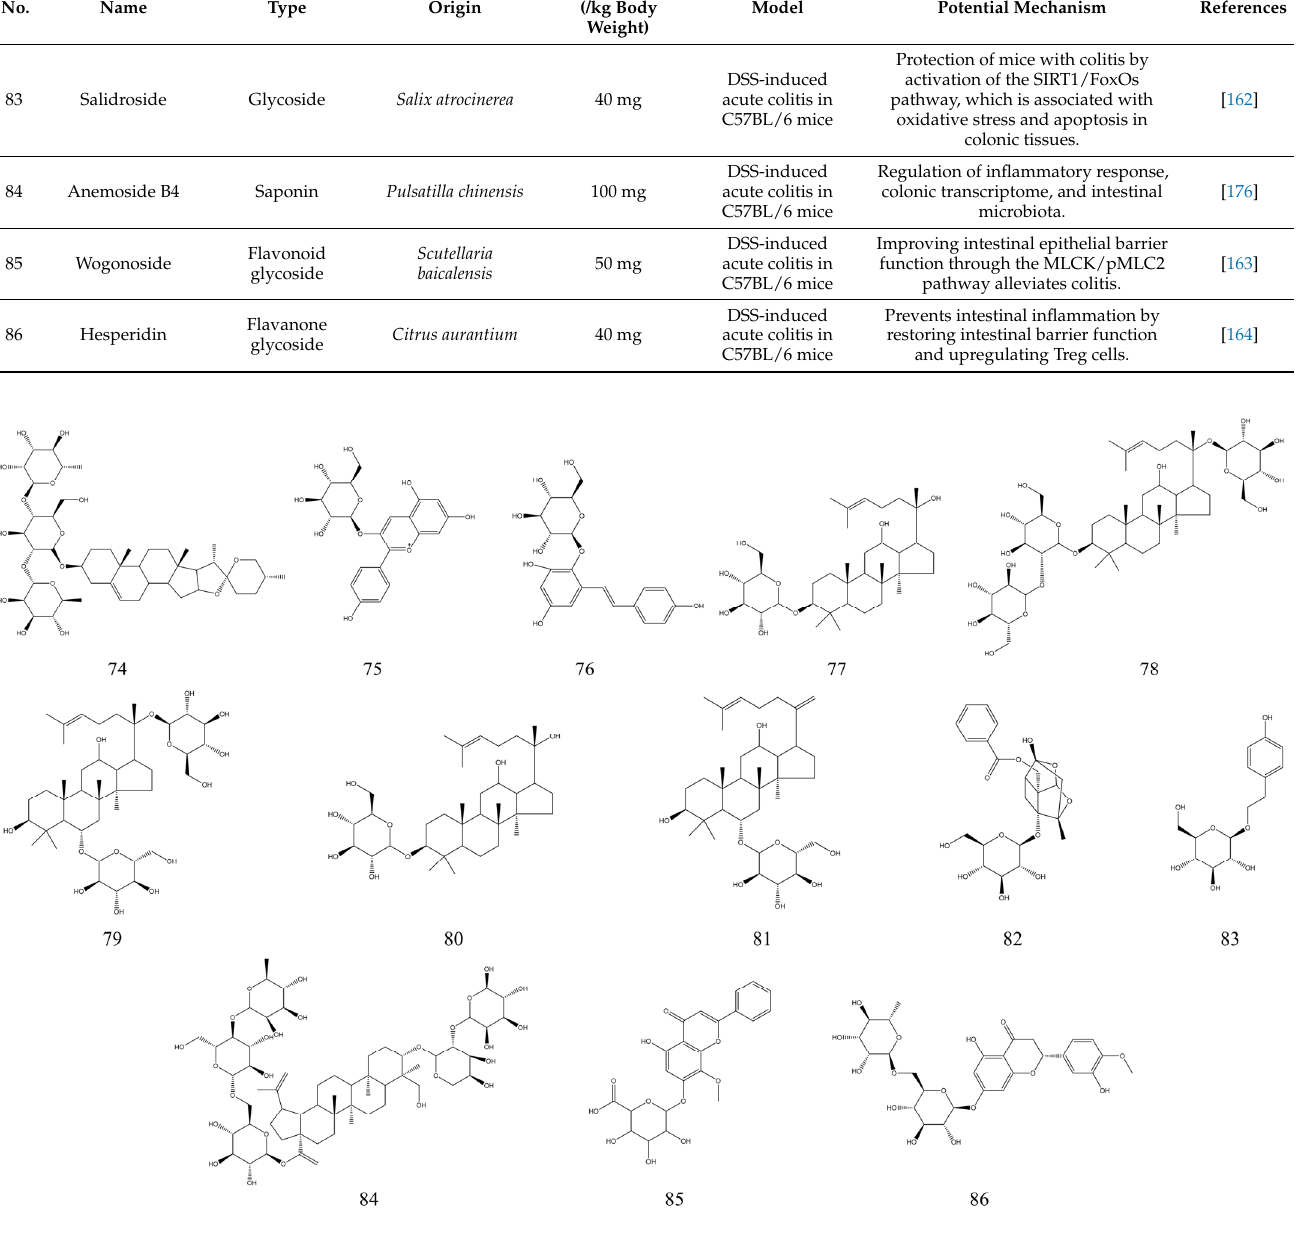
Figure 6. Structural formulae of glycosides with IBD therapeutic effects. Table 3. In vivo therapeutic effects of glycosides on experimental IBD.